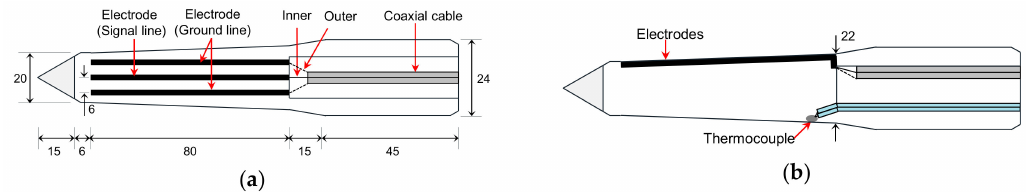
Figure 2. Schematic drawing of the PTDR module: ( a ) top view; ( b ) side view. The units are in millimeters. The thickness of the electrodes is 1.5